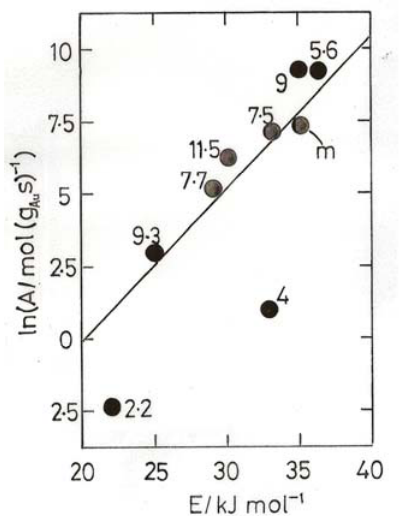
Figure 5. Compensation plot for CO oxidation over Au/TiO various values of pH (indicated) [43]; the point m represents one made on a monolith support